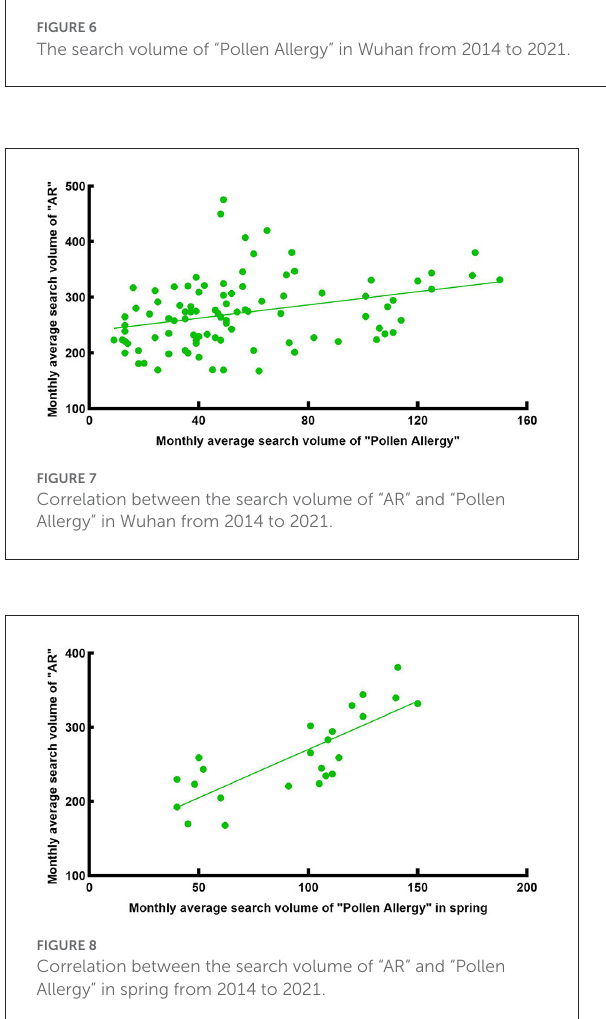
As a city located in central China, the most common allergens causing AR in Wuhan include both pollen and dust mites. Therefore, we analyzed the correlation between the monthly average SV in Wuhan of “Allergic Rhinitis” and the SV of “Mites + Pollen Allergy” (Figure 11), representing the